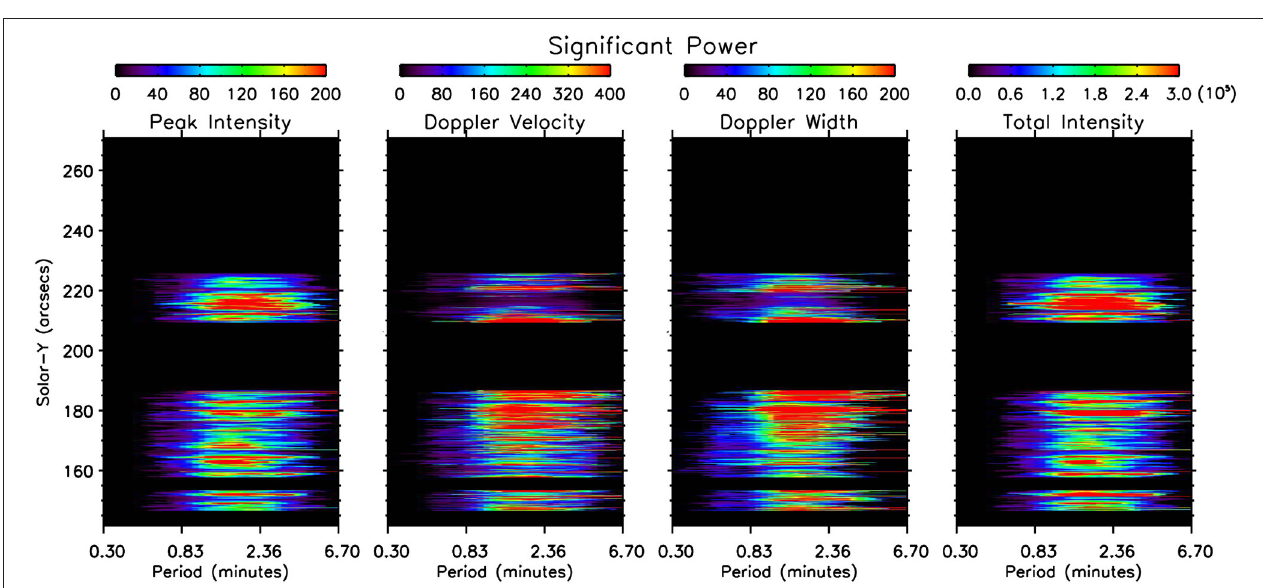
FIGURE 3 | Power maps showing the significant power obtained from the SiIV1400Å SJ intensity variation in the period range of 1–2 min and 2–4 min. The rightmost panel shows the average SJ intensity image with contours of significant power in 1–2 min periods in red and 2–4 min in yellow, delineating the bright regions of the moss.